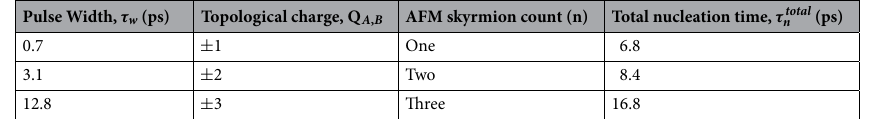
Pulse Width, τ w